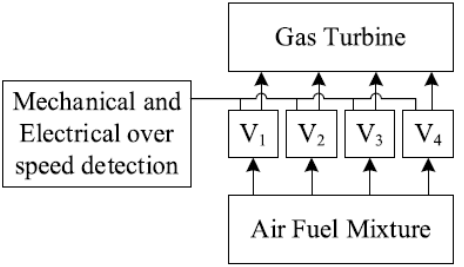
Figure 4. The overspeed protection of a gas turbine system.